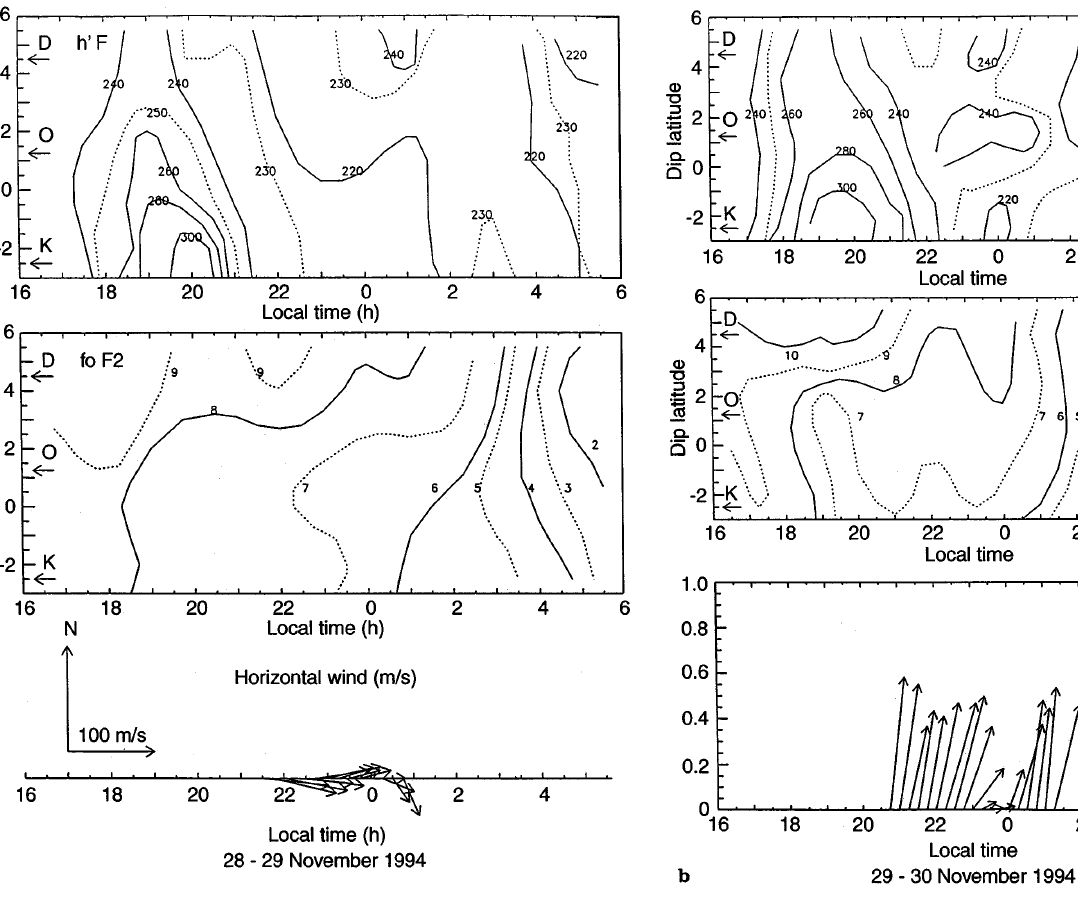
Fig. 2a, b. As a function of the dip latitude and local time, winter solstice night-time evolution of: Top panel : h ’ F , altitude of the F2 layer bottom; middle panel : f oF2 expressed in MHz; lower panel :